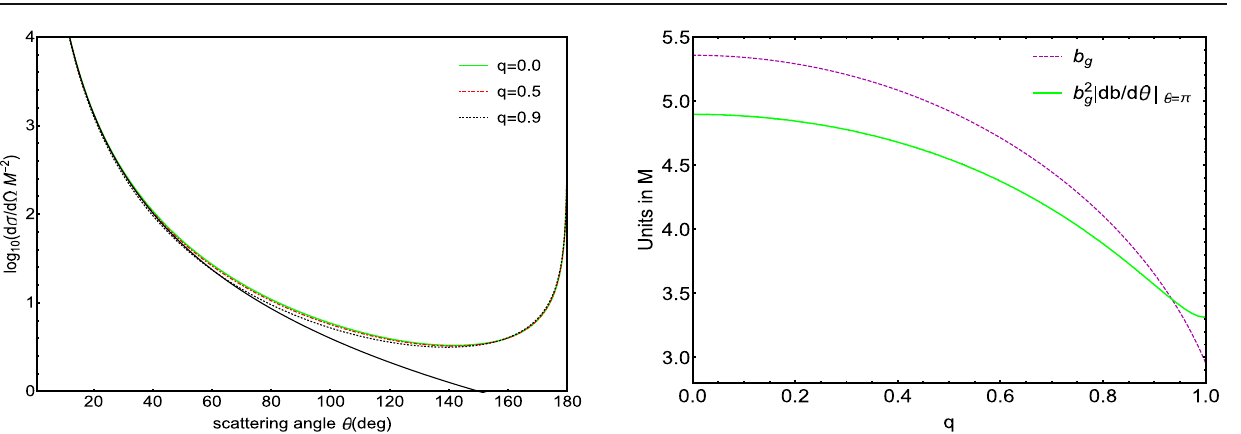
Fig. 2 Glory scattering parameters as functions of